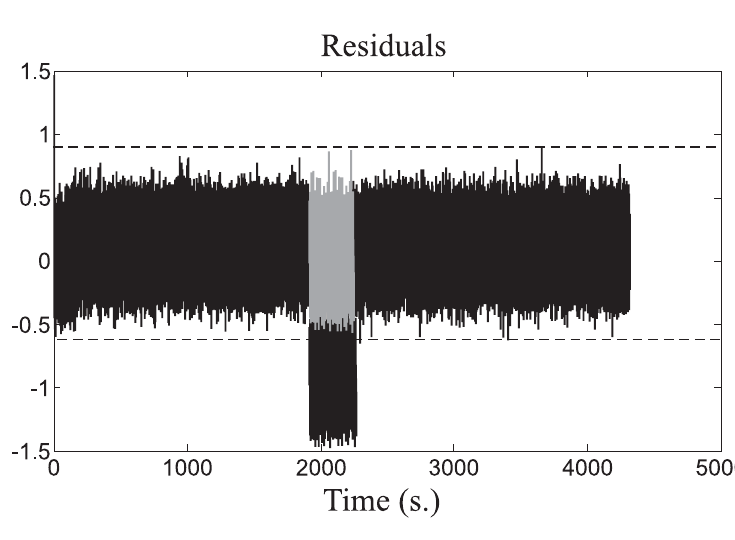
( t ) for the fault Case 1 . I i